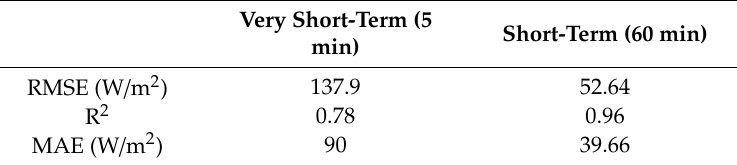
Figure 7. Decomposed time series dataset to stationary and non-stationary components ( a ) 5-min interval ( b ) 60-min interval. Table 8. Accuracy levels of the PAHM